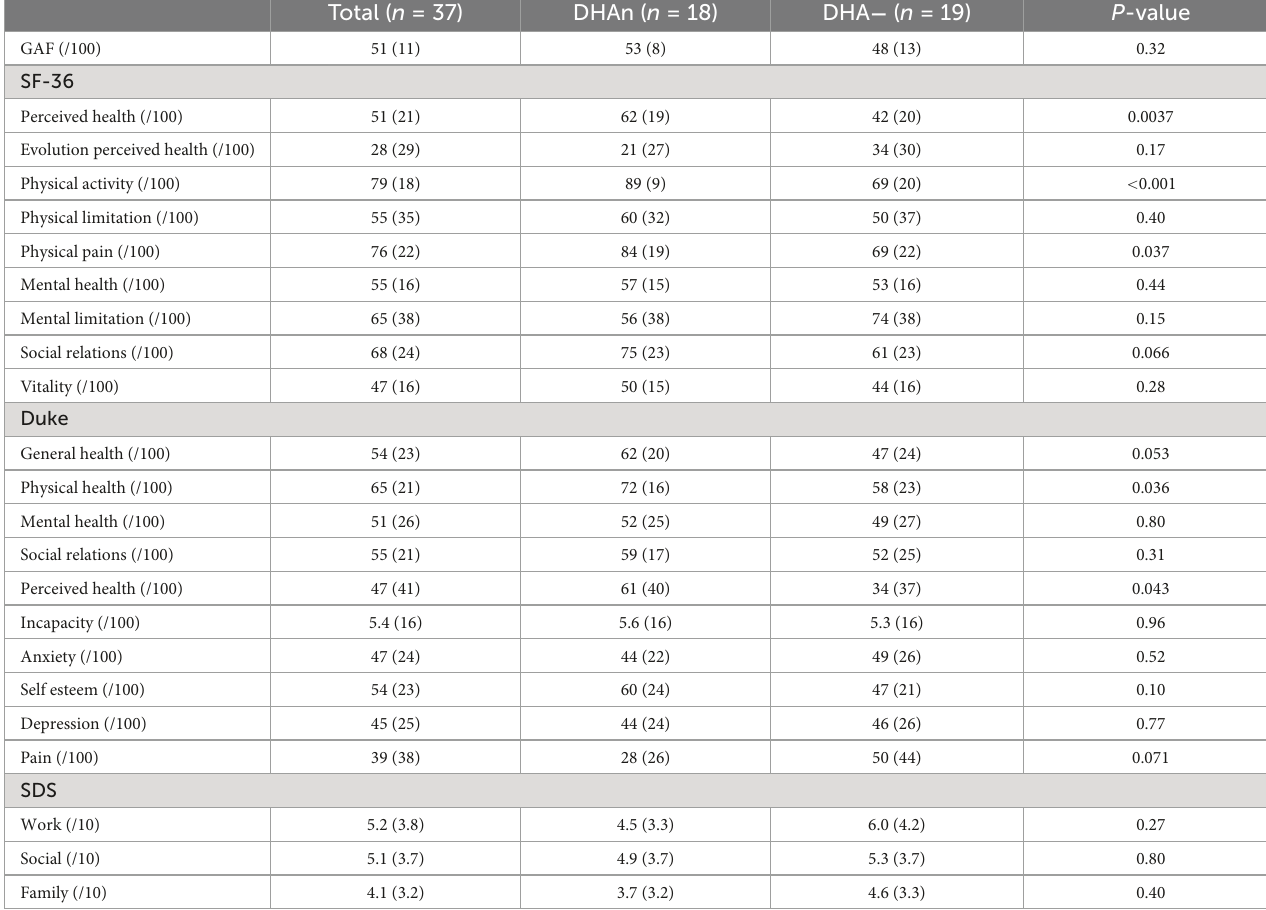
TABLE 3 Results on the quality of life comparing the two